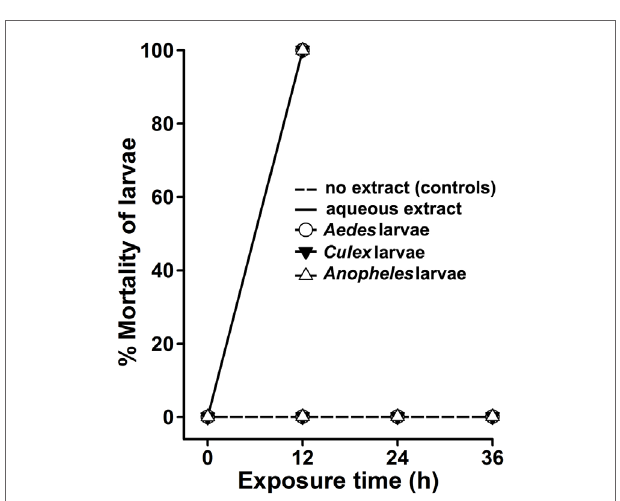
FigUre 3 | effects of seasonal variations on Agave -mediated larvicidal activity. A. aegypti larvae were exposed to various doses (0–200 μ g/ml) of aqueous extracts prepared from the plant leaves that were growing outside in an open area during (a) summer or (B) winter season. The percentage mortality of larvae at each time point was calculated against the sham-treated controls (0 μ g/ml) and represented as the mean ± SD of triplicates.